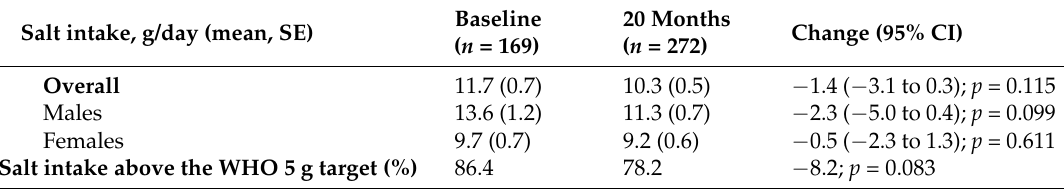
Table 3. Changes in estimated mean Fiji population salt intake (after weighting age, sex, and